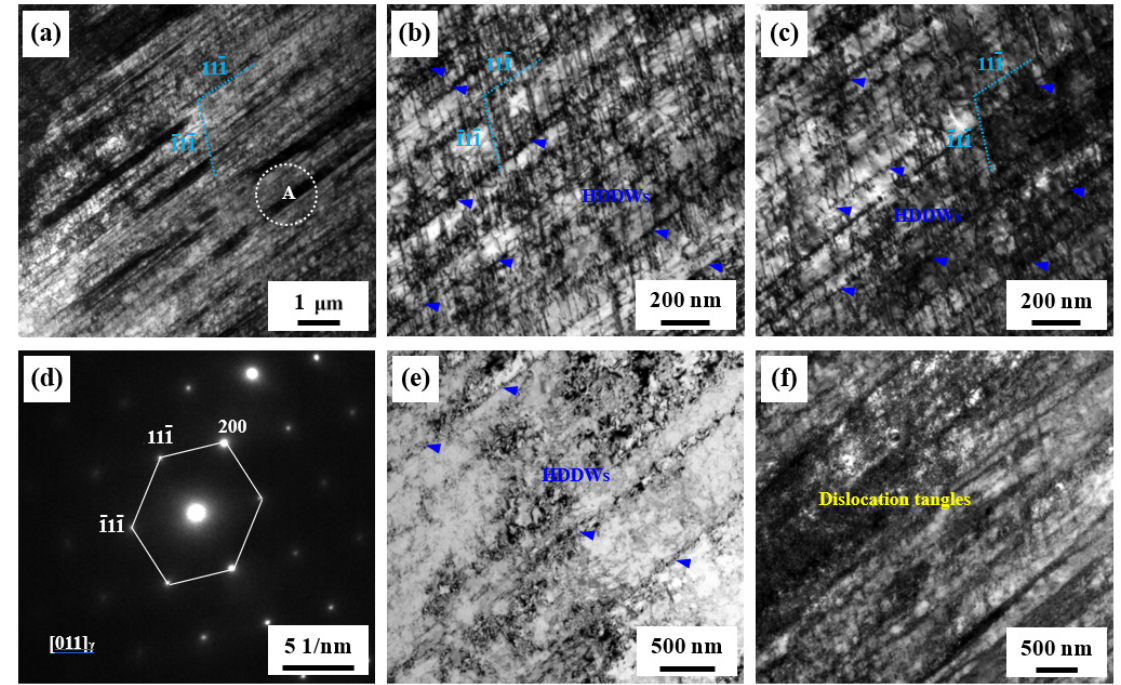
Figure 7. TEM images of typical microstructures of the steel after tensile deformation at 4 K. ( a – c ): Bright-field TEM images, showing HDDWs and planar dislocation slipping. ( d ) SAEDP of the outlined region A in ( a ). ( e , f ): Bright-field TEM images, showing HDDWs and dislocation